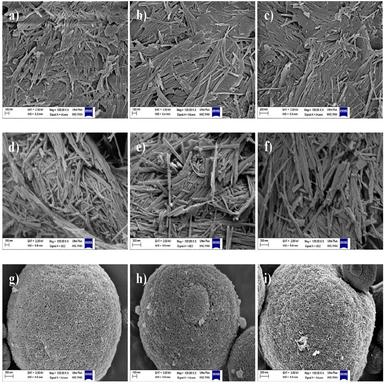
Scanning electron microscope images of: (a) PAL; (b) PAL/A; (c) PAL/P; (d) SEP; (e) SEP/A; (f) SEP/P; (g) HAP; (h) HAP/A; (i) HAP/P.